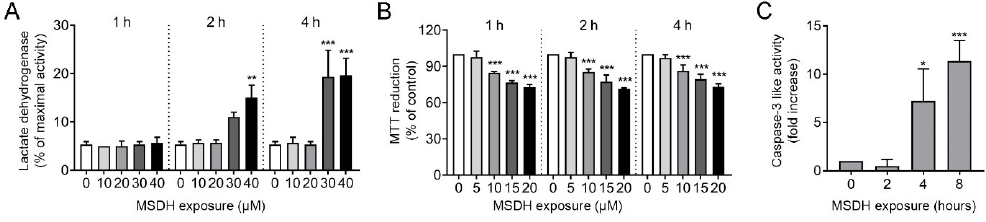
Figure 4. Concentration-dependent toxicity of MSDH. Fibroblasts were exposed to MSDH and toxicity was analyzed using ( A ) LDH activity in conditioned media after 1, 2 and 4 h of MSDH exposure (maximal LDH activity was obtained by total cell lysis), ( B ) cell viability using the 3-(4,5-dimethylthiazol-2-yl)-2,5-diphenyltetrazolium bromide (MTT) assay after 1, 2 and 4 h of MSDH exposure and, ( C ) caspase-3 like activity (15 µ M MSDH). The results are shown as mean ± SD ( n = 3) * p < 0.05 and *** p < 0.001 compared to untreated control at each time point. The toxic properties of LDs, when added to cells at low concentrations, are initiated through mainly lysosomal-specific reactions, since the LDs are accumulated within lysosomes due to protonation in the acidic environment. As the concentration increases, lysosomal membrane stability is compromised [24]. Using the sensitive marker of lysosomal membrane permeabilization, galectin- 1 [35], we found that 15 μM MSDH induced the translocation of galectin-1 from the cytosol (diffuse staining) to the lysosomes (puncta) indicating damage to the endo-lysosomal membranes (Figure 5A). Image analysis showed a time-dependent increase in the number of puncta-positive cells (Figure 5B). In accordance, the release of cathepsin B from the lysosomal lumen to the cytosol was detected by immunocytochemical staining (Figure 5C), and quantified by estimating co-localization between cathepsin B and lysosomal-associated membrane protein-2 (LAMP2) (Figure 5D). Reduced colocalization indicates the release of cathepsin B from the lysosome to the cytosol. Also, the number of Lysotracker-positive lysosomes was substantially reduced already after 10 min of MSDH exposure, demonstrating the loss of the proton gradient in the damaged lysosomes (Figure 5E). Immunoblotting of cathepsin B in cytosolic fractions showed that MSDH caused an almost instant injury to the lysosomal membrane, as cathepsin B was released within 5 min after MSDH exposure (Figure 5F). This was confirmed by a concomitant increase in cytosolic activity of the lysosomal hydrolase β-N- acetyl-glucosaminidase (NAG). The enzymatic activity was significantly increased in the cytosol 15 min after MSDH addition (Figure 5G) and reached its maximum activity within 30 min. By combining the results of LDH activity (Figure 4A) and NAG activity, we obtained a suitable concentration and exposure time for MSDH; 15 μM for 1 h, where we achieved significant LMP and no plasma membrane damage (Figure 5H).